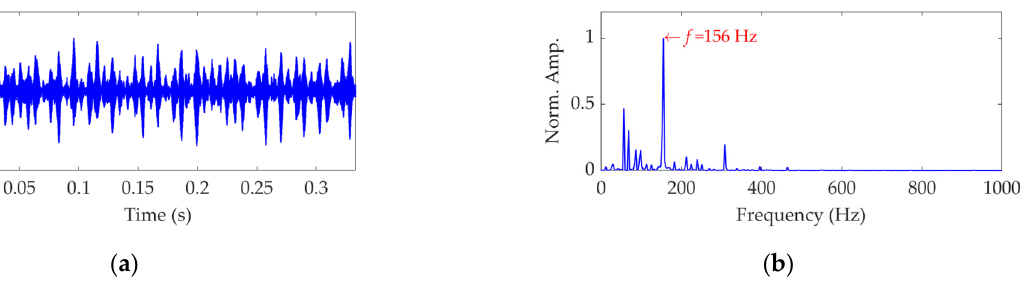
Figure 16. The target mode obtained by VMD: ( a ) time − domain waveform and ( b ) SES.